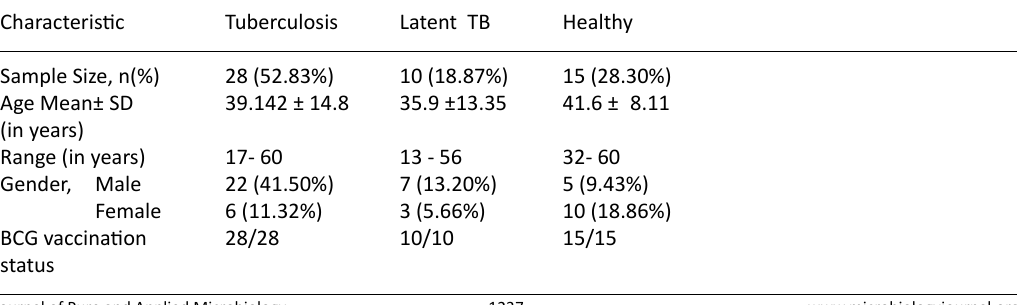
table 1. Demographic Characteristic of the Participants Characteristic Tuberculosis Latent TB